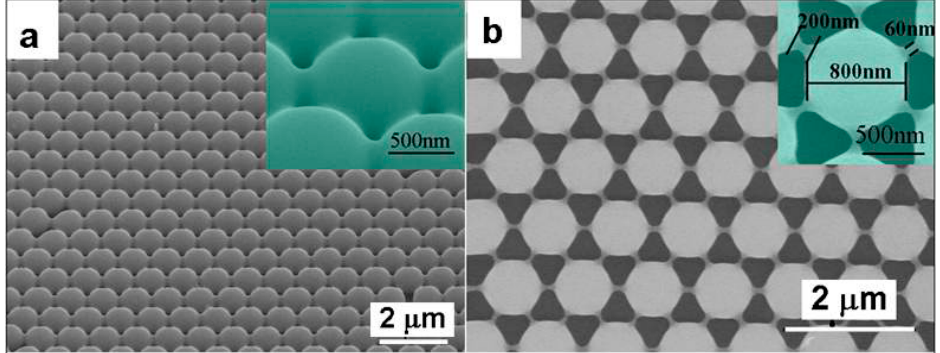
Figure 5. The morphologies before and after Ar + plasma etching the heated PS monolayer. ( a ): The SEM image of the close-packed PS colloidal monolayer with 1 μ m in PS sphere diameter on the Si wafer after heating at 120 °C for 2.5 min, showing deformed PS spheres. The inset is a local magnified image. ( b ): The SEM image after Ar + plasma etching the PS monolayer in (a) for 10 min (100 W in input power), showing non-close-packed and dualistic structure , and the inset: a magnified image of a single etched PS sphere (Guangqiang Liu et al. [29]).